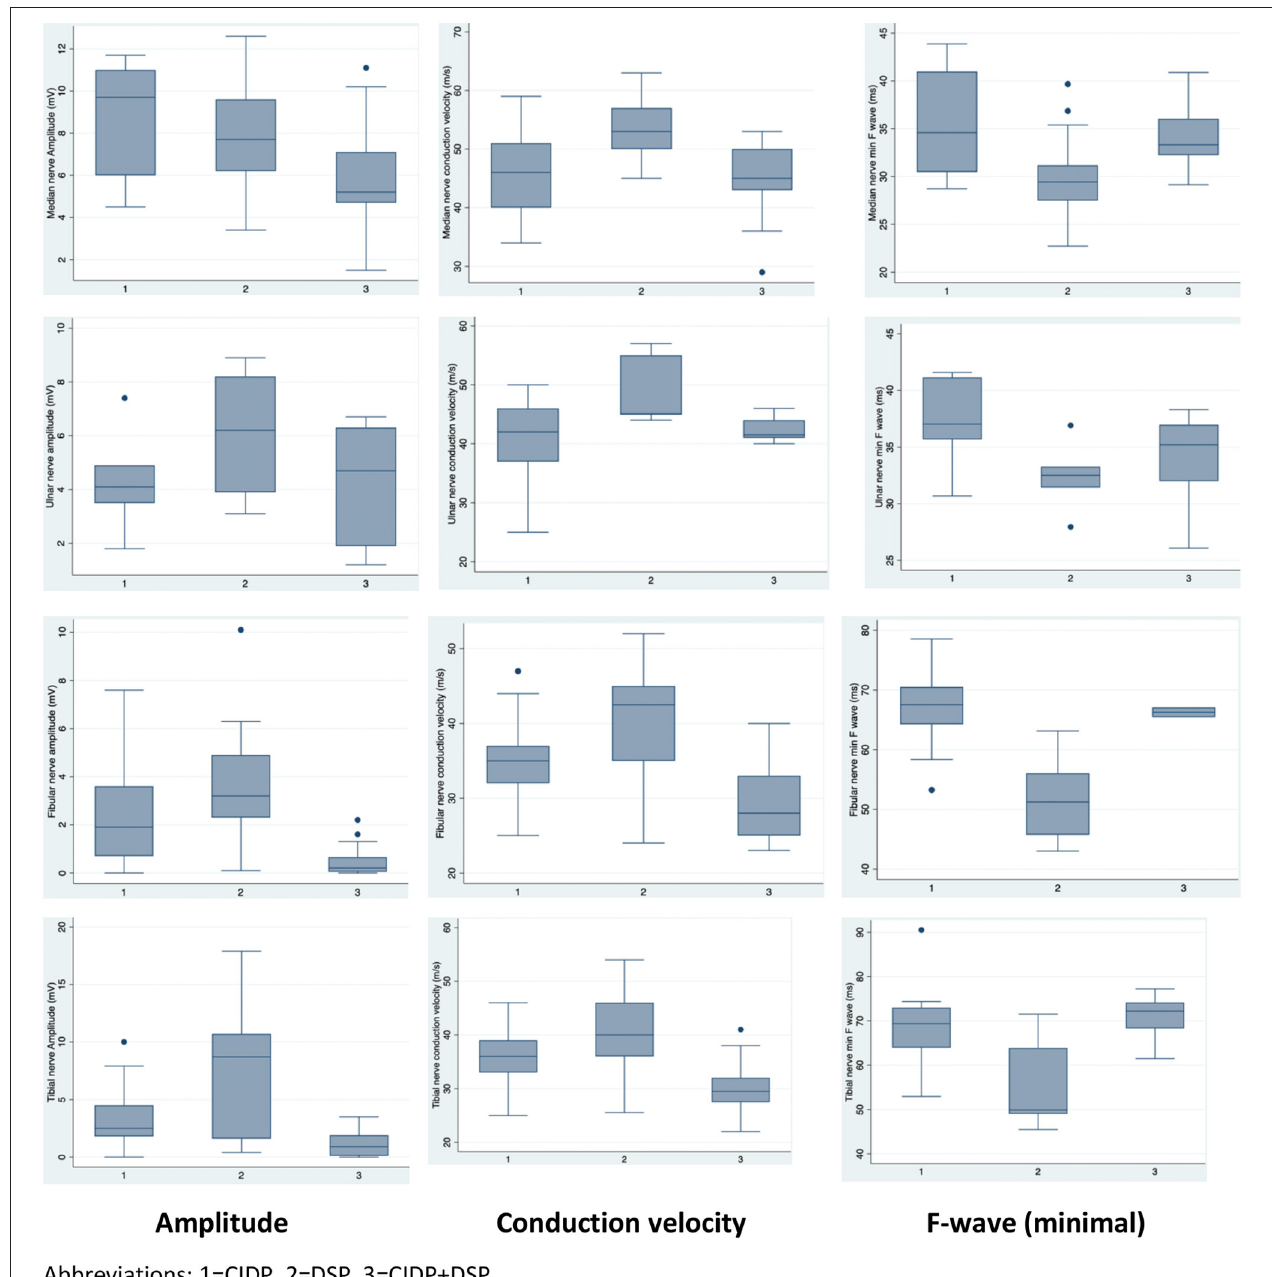
FIGURE 1 | Electrophysiologic data by